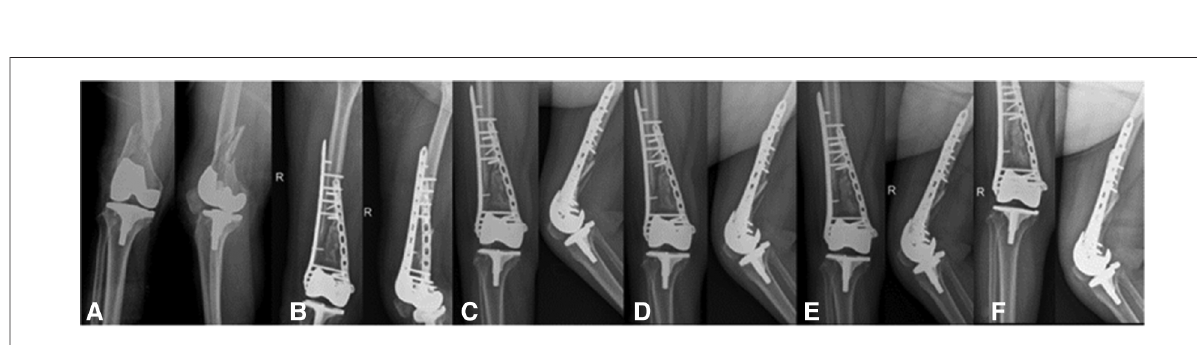
FIGURE 3 Anteroposterior and lateral radiographs of the right knee: preoperative x-ray image ( A ), postoperative x-ray images ( B ), radiograph 7 months after surgery ( C ), radiograph 9 months after surgery ( D ), radiograph 21 months after surgery ( E ), radiograph 34 months after surgery ( F ).